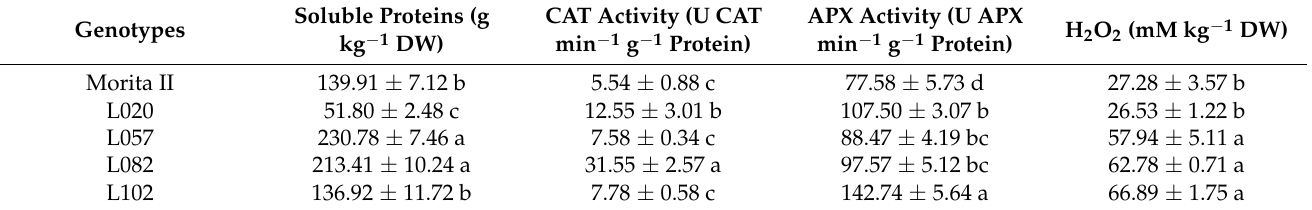
Table 1. Soluble proteins, catalase and ascorbate peroxidase activity, and hydrogen peroxide con- centration in genotypes of 60-day-old Stevia rebaudiana . All values denote the mean ( ± SD) of five repetitions. In each parameter, values followed by different letters are statistically significant at p ≤ 0.05.